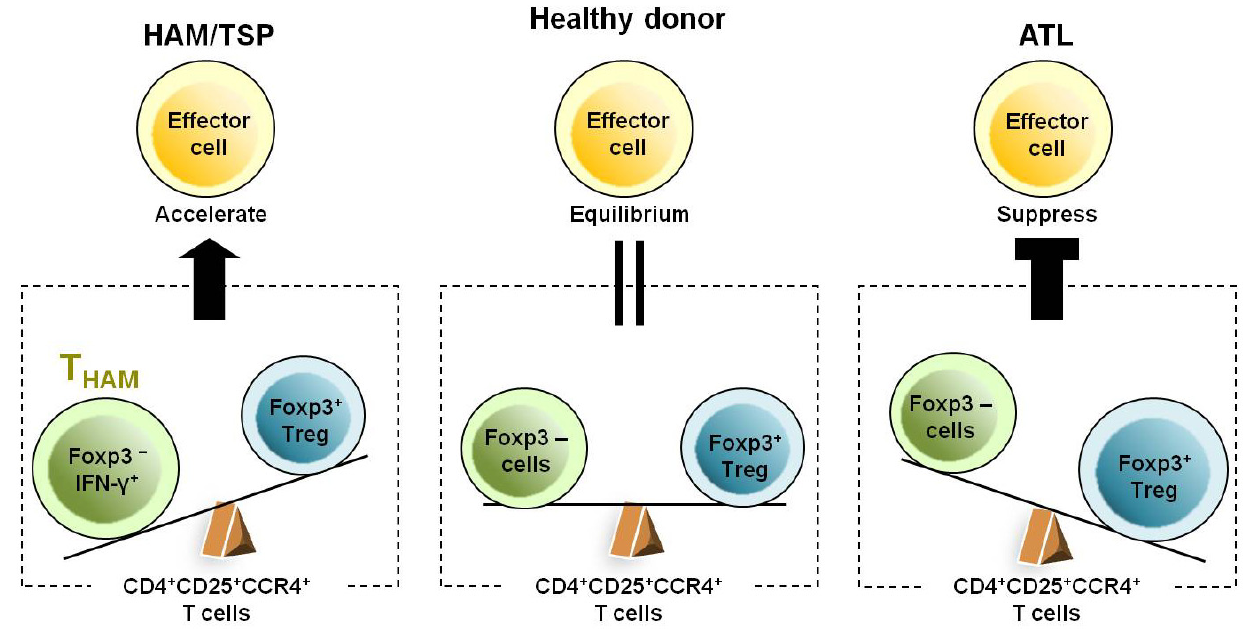
Figure 3. Differential immune responses and T cells in HAM/TSP and adult T cell leukemia/lymphoma (ATL)